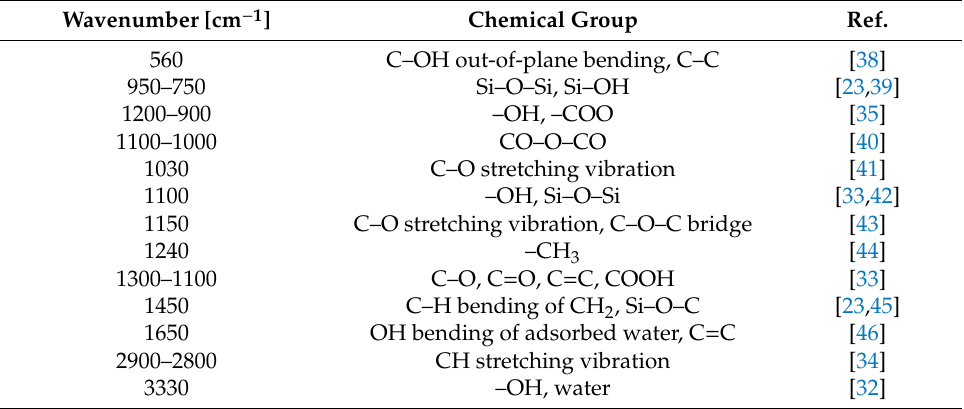
Table 2. Wavenumber values assigned to the chemical